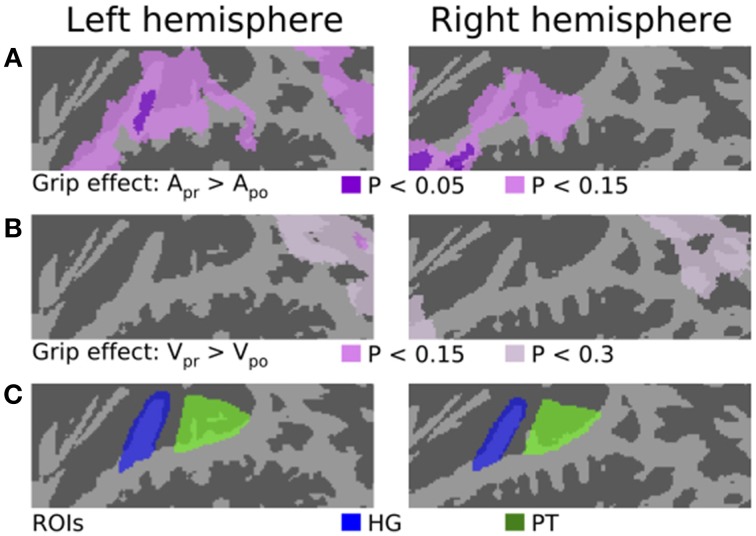
The effect of grip and ROIs. (A) The areas where activations were stronger during Apr than Apo blocks. The results are plotted with two thresholds (corrected P < 0.05 and corrected P < 0.15). The opposite contrast (Apo > Apr) showed no significant effects. (B) The areas where activations were stronger during Vpr than Vpo blocks (corrected P < 0.15 and corrected P < 0.3). (C) ROIs in HG and PT.